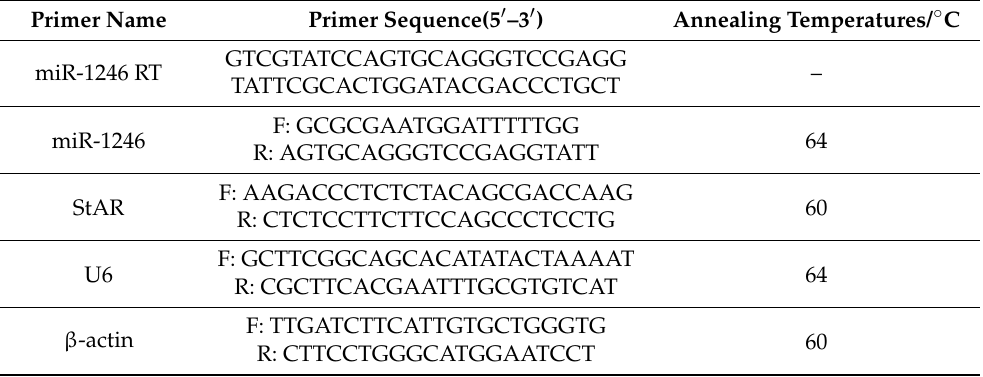
Table 2. Sequences of miR-10b and mimics